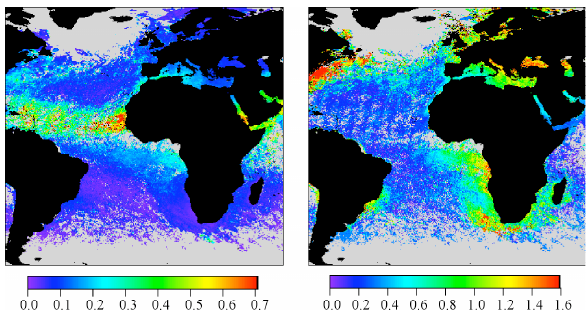
Fig. 6. Monthly mean maps of the aerosol optical thickness at 0.87 µ m (left) and the Angstrˆom coefficient (right) for June 2003 as retrieved from POLDER-2